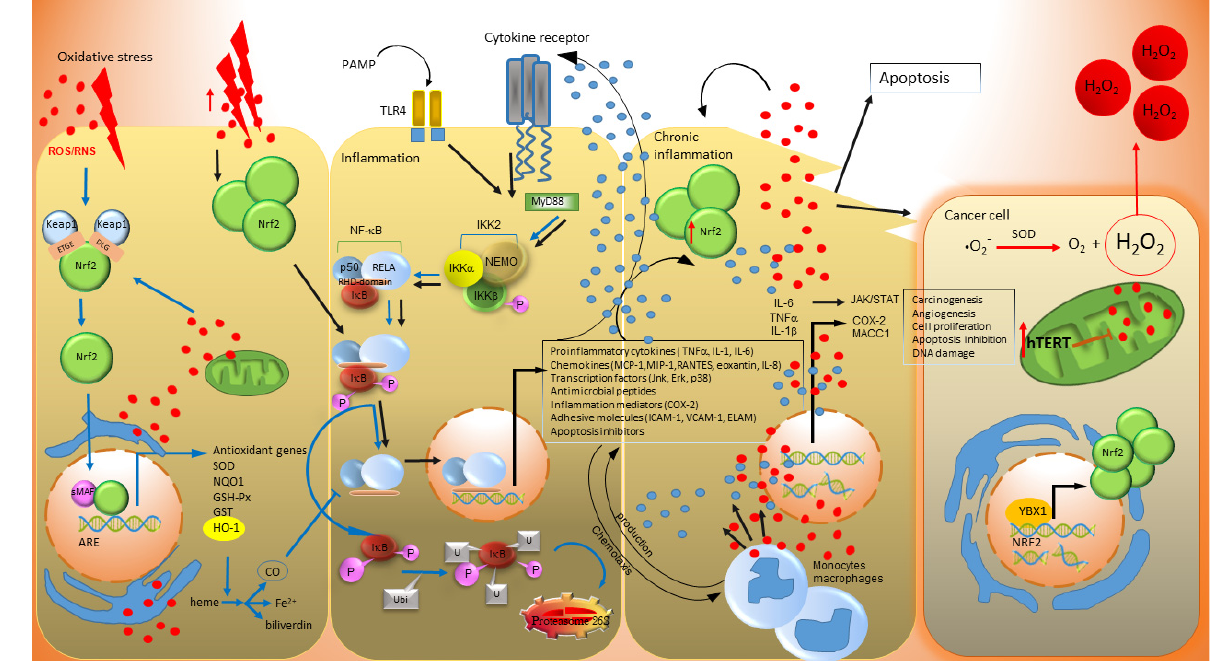
Figure 1. Mechanism of colorectal carcinogenesis. In the phase when the colon cell is exposed to oxidative stress (OS), the Nrf2 protein is activated. Its level in the cell’s cytoplasm increases, which correlates with an increase in the cell’s antioxidant capacity and content of antioxidant enzymes (e.g., HO-1). The antioxidant products prevent NF- κ B from entering the nucleus by inhibiting pro- inflammatory cytokines. This is the one of several mechanisms by which the cell protects itself from OS. However, if the cell goes into the inflammation phase, the level of Nrf2 increases to such an extent that there is a nuclear translocation of NF- κ B, leading to the massive production of pro-inflammatory cytokines. The result is inflammation, since if the cell of the intestinal mucosa can no longer defend itself and exhausts its antioxidant capacity, the cell enters a phase of chronic inflammation. Moreover, oxidative modifications of DNA may result in alterations in bases, strand breaks, the inactivation of tumor suppressor genes, or the overexpression of proto-oncogenes. The damaged cell subsequently enters apoptosis or transforms into a tumor cell. In a transformed cell, the auto- or self-antioxidant system hTERT is activated, reducing the ROS. This mechanism could be considered a protective mechanism by the tumor cell to ensure its existence and proliferation. ROS produced by the tumor cell are subsequently transported out of the cell and thus cause oxidative stress to surrounding cells. At the same time, extracellular ROS also influence the microenvironment to ensure the production of energy and metabolites for tumor cells. Blue arrows show the regulatory mechanism of cell protection against OS. Black arrows show the effect of excessive OS on a cell during the transformation into a tumor cell. The red dots represent ROS/RNS, while the blue dots depict inflammatory cytokines and chemokines. Pathogen-associated molecular patterns (PAMP molecules): lipopolysaccharides, toxins, lipoteichoic acid, peptidoglycans, lipoproteins, flagellin, glucanases, chitin and viruses. The original figure for this review was made by the Zoner Photo Studio X (Zoner a.s.,